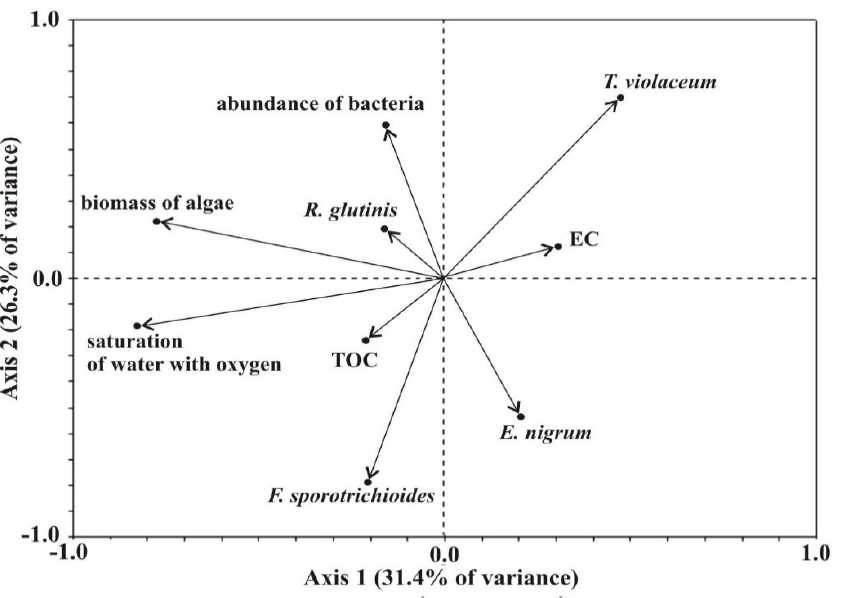
Figure 2. Diplot of redundancy analysis (RDA) results evaluating the relationships between the four species of mycoplankton characterized by the significant ecological importance and environmental variables. Environmental variables and fungal species are shown as arrows. The vector orientations represent the direction of the greatest change; vector lengths represent relative importance, while perpendicular arrows indicate no correlation.